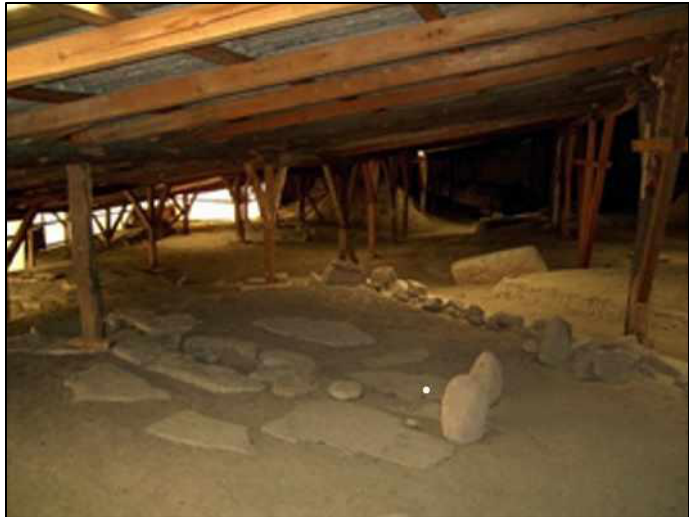
Figure 27. The originally relocated location of Lepenski Vir. The original location was long under water, although some objects and all the sculptures from it were transferred to higher ground [38,